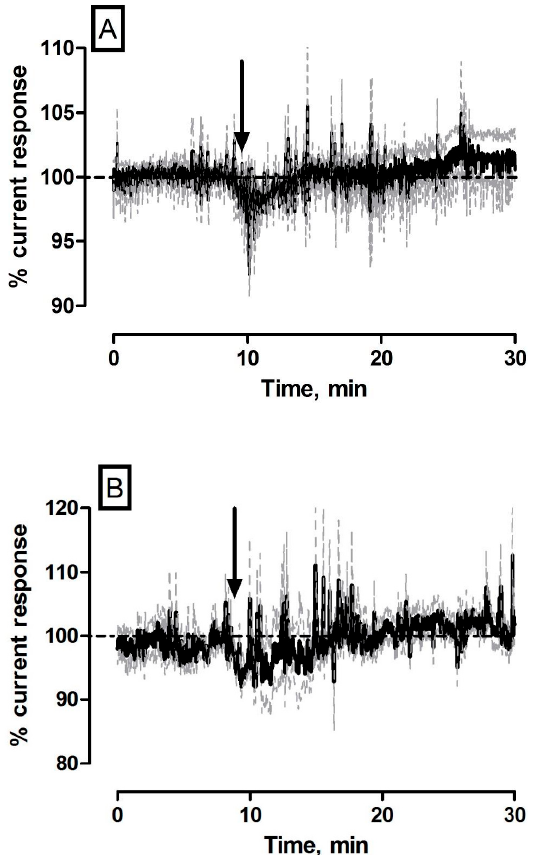
Figure 1. Averaged raw data % current response of ( A ) NO and ( B ) O 2 sensors implanted in the striatum of NOD SCID mice ( n = 5) to a 1 mL·kg − 1 injection of 0.9% saline. Arrows indicate point of injection. Mean % current response represented by black trace, % error represented by grey trace.